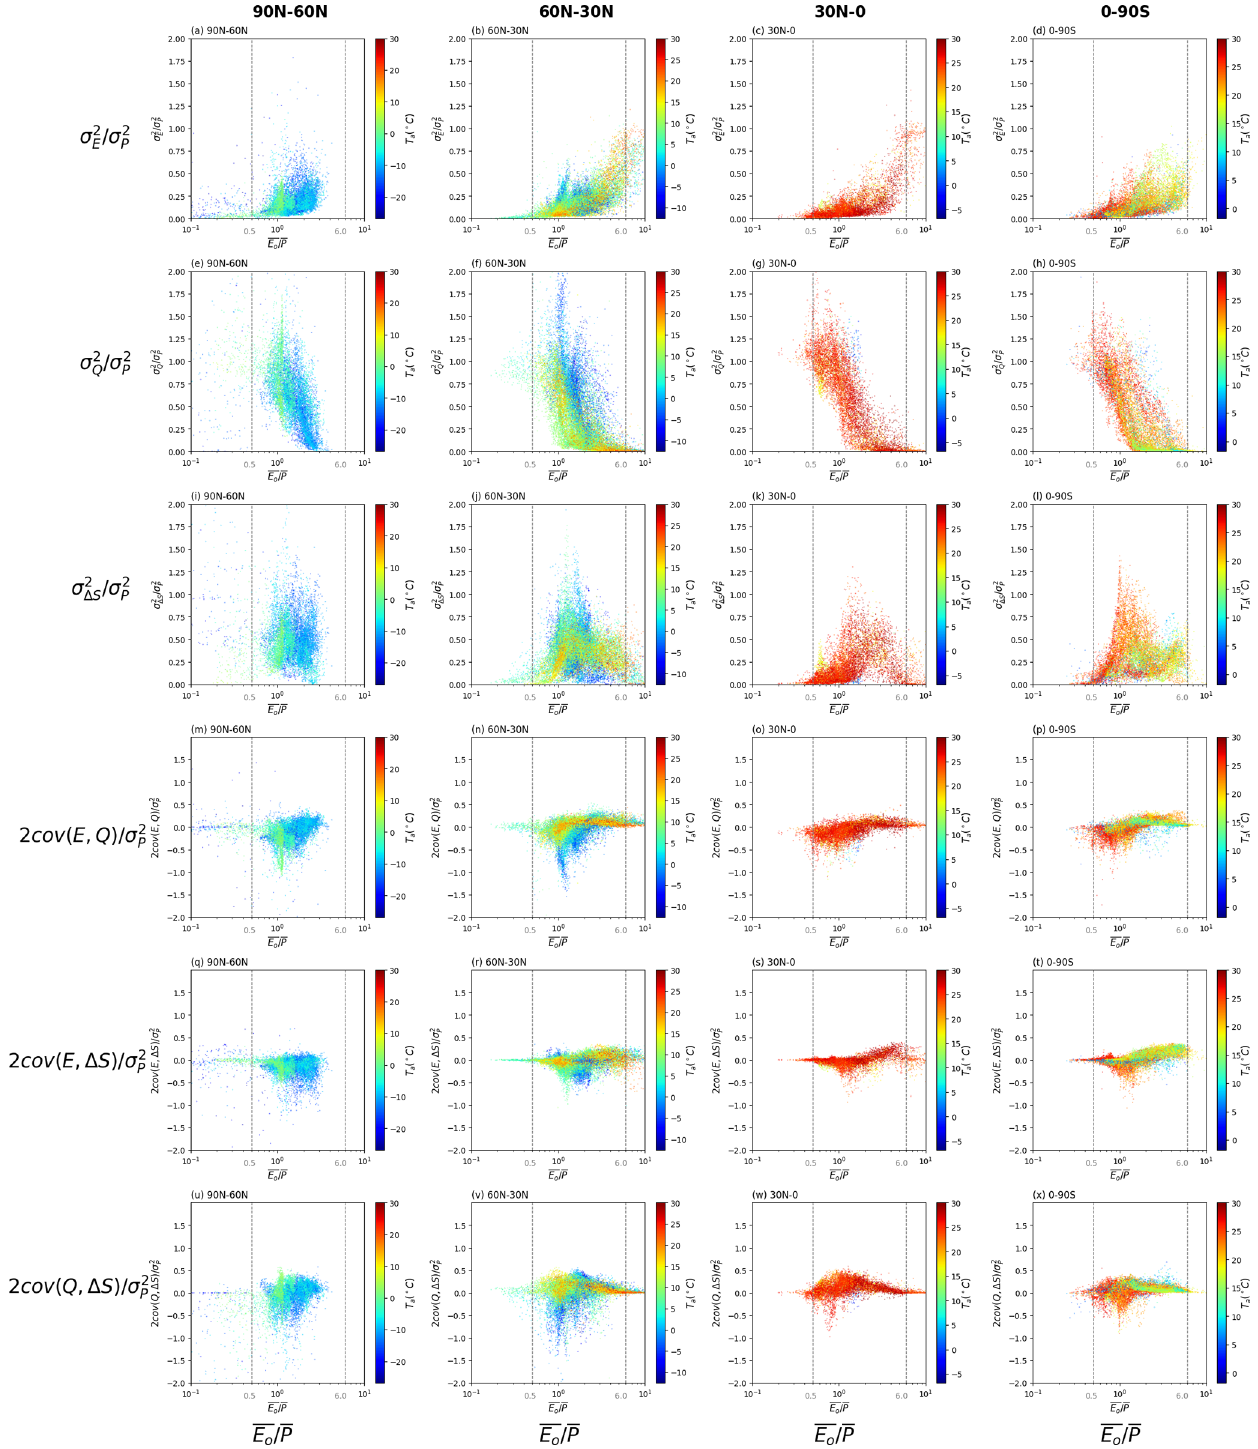
Figure 8. Relation between water cycle variances and covariances (see Fig. 3b–g) as a fraction of the variance for P ( σ 2 index ( E o /P ) for grid cells over different latitude ranges (i.e. 90–60 ◦ N, 60–30 ◦ N, 30–0 ◦ N and 0–90 ◦ S). The colours relate to the mean air temperature ( T a ). Note that we have multiplied the covariances by two (see Eq. 2). The vertical grey dashed lines represent thresholds used to separate extremely dry ( E o /P ≥ 6 . 0) and wet ( E o /P ≤ 0 . 5)